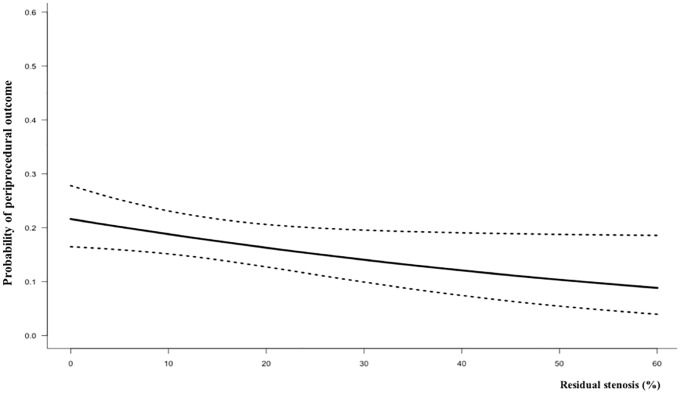
Probability of periprocedural outcome according to the degree of residual stenosis.